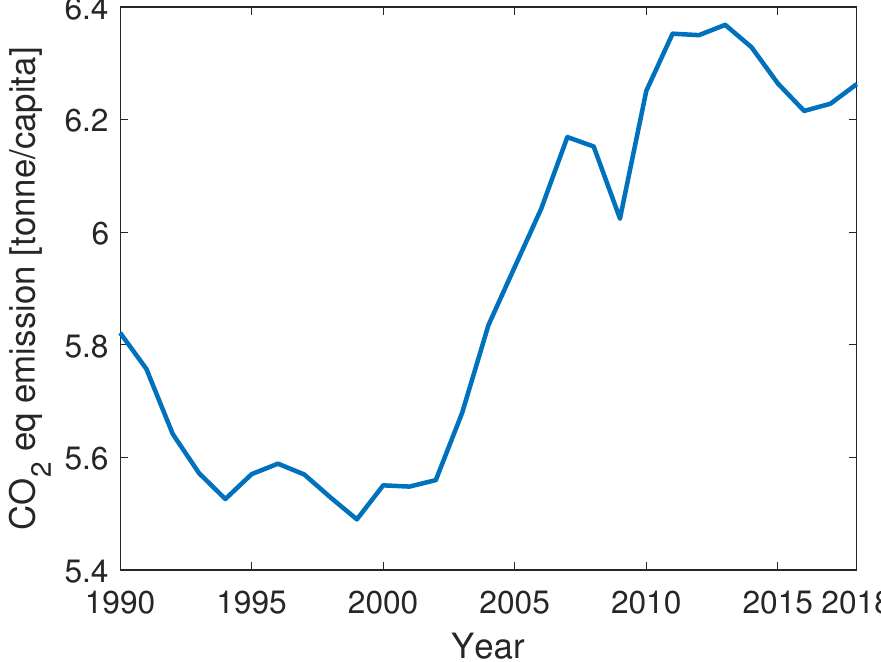
Figure 5. The total CO 2 equivalent emission per capita in the world. The great recession in 2008 can be well recognized. Figure 6 indicates the sectoral distribution of greenhouse gas emission per